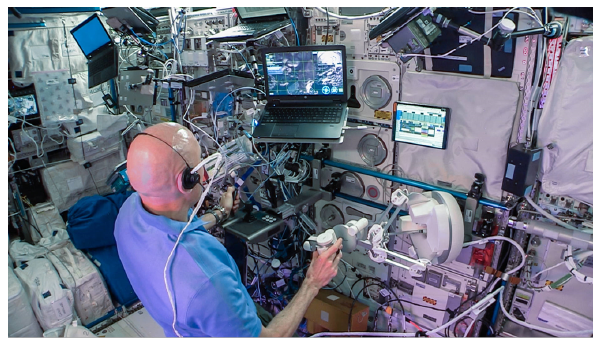
Figure 4. Astronaut Luca Parmitano operating INTERACT from on- board the